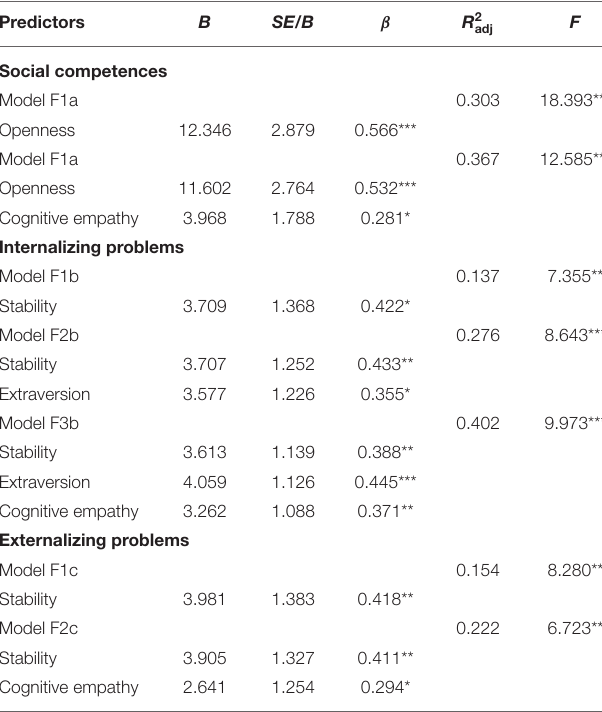
TABLE 7 | Predictors of children’s social skills according to children’s individual characteristics and their skills in empathy as perceived by mothers. Predictors B SE/B